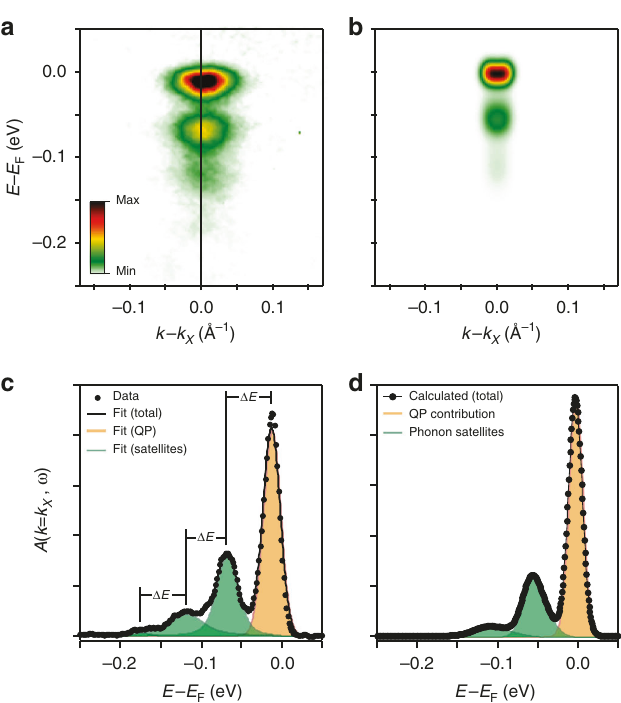
(eV)–0.6–0.5–0.4–0.3–0.2–0.10.00.1 Fig. 3 Doping-dependent plasmonic polarons. a – d Evolution of the measured spectral function of Eu 1 − x Gd x O with increasing charge carrier doping, showing not only a strong increase in band fi lling of the quasiparticle band, but also a substantial evolution of the satellite peak structure. The insets show Fermi surface contours ( h ν = 137 eV), indicating the increasing doping. While replica bands can still be observed to high doping, as clearly evident as peak-dip- hump structures in measured EDCs ( e ), these show a strong broadening and blue-shift relative to the quasiparticle peak with increasing doping. f – i Our ab initio calculations reproduce this general trend when both electron − phonon and electron − plasmon interactions are considered, identifying the hump feature in the higher-density samples as arising from plasmonic